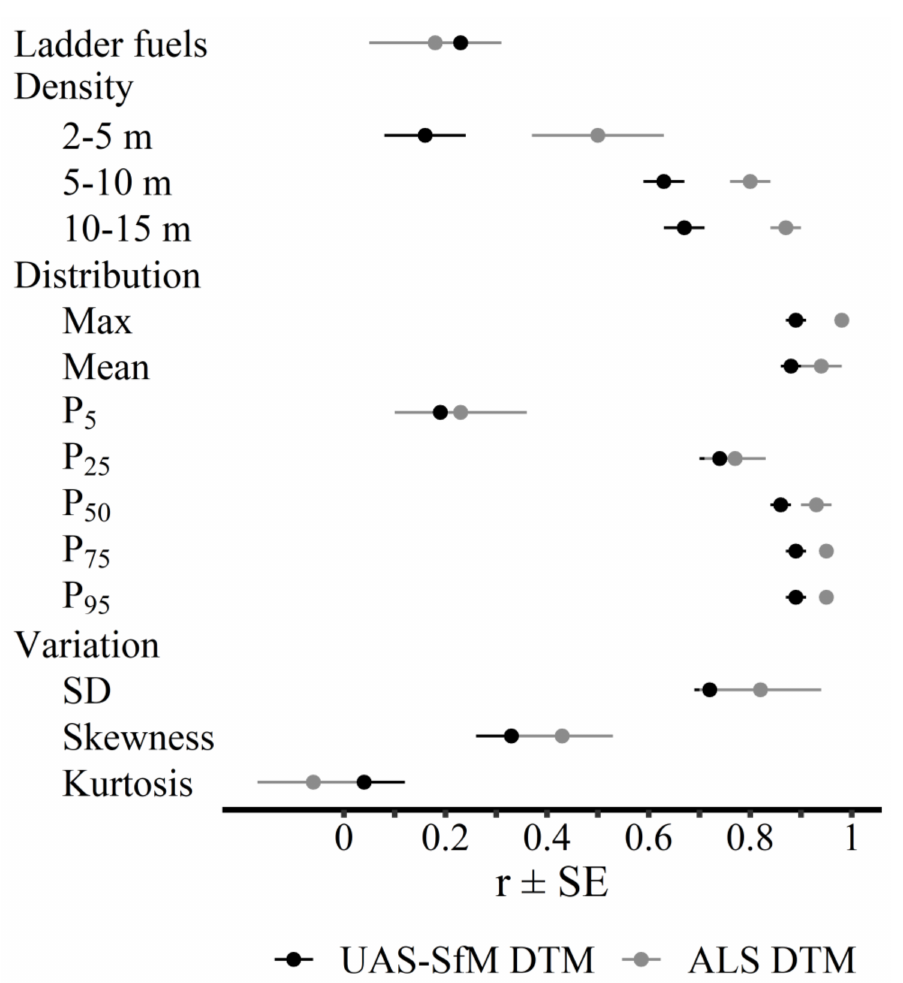
Figure 6. Comparison of Pearson correlations for point cloud height metrics extracted from UAS-SfM height normalized using either UAS-SfM DTM or ALS DTM across all forest types. Coefficients and their standard errors computed using 10,000 bootstrap replicates between UAS-SfM and